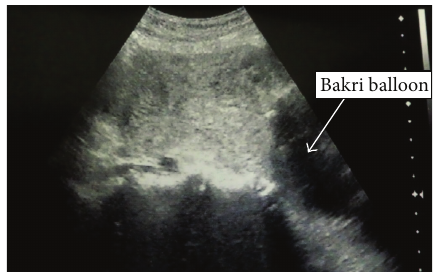
Figure 2: The uterine fundus was pushed up with a balloon containing 300 mL of physiological saline. The shape of the uterine fundus was irregular and indistinct, and complete reduction was not achieved.